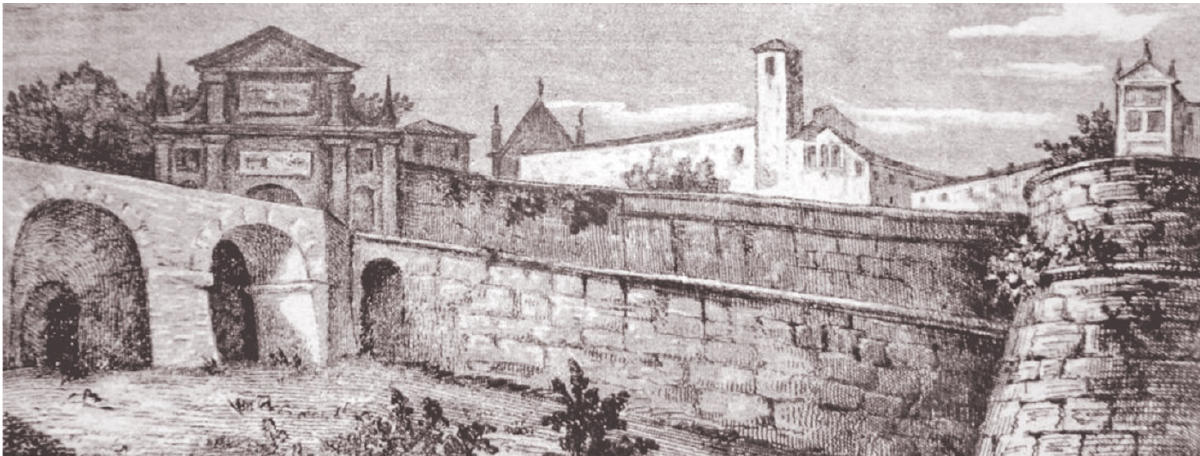
Figure 3. The complex of Sant'Agostino : southern view from under the walls of the Baluardo di Sant'Agostino , 1860 (detail from the lithograph printed by the publisher Vallardi, “Sant'Alessandro, protector of the city of